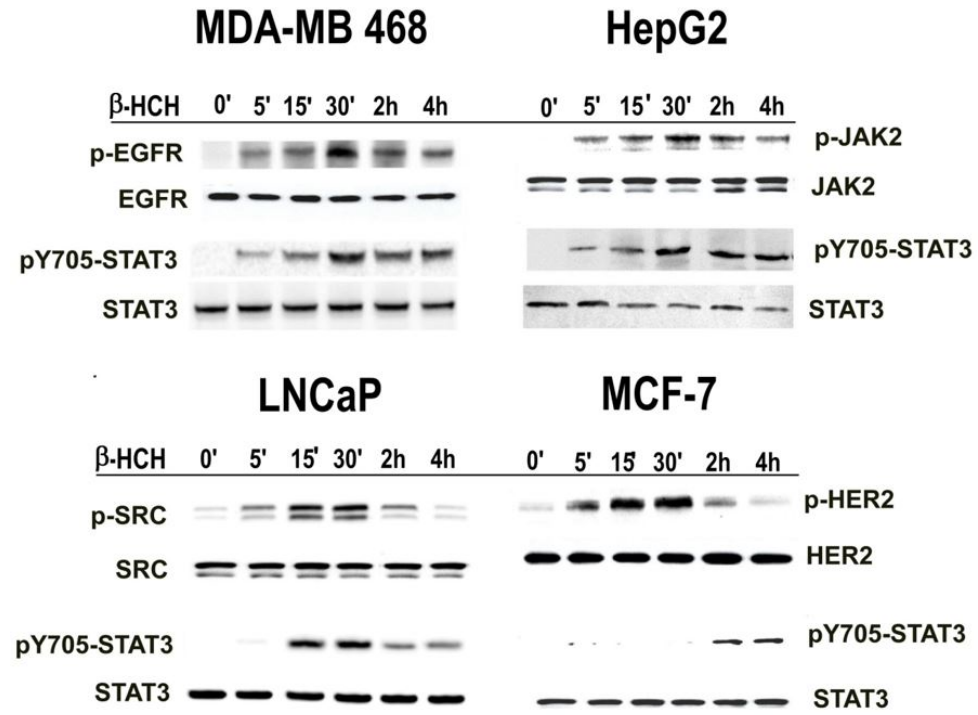
Figure 1. Evaluation of the signaling pathways triggered by β -hexaclorocyclohexane ( β -HCH). Immunoblot analysis of the time-course assay performed on human prostate cancer (LNCaP), human breast cancer (MCF-7 and MDA-MB 468), and human hepatoma (HepG2) cells treated with 10 µ M β -HCH. Samples were analyzed for signal transducer and activator of transcription 3 (STAT3) and each cell line for a specific membrane or membrane associated tyrosine kinase receptor: EGFR in MDA-MB 468 cells, JAK2 in HepG2 cells, SRC in LNCaP cells and HER2 in MCF-7 cells. Both unmodified and the corresponding phosphorylated form were detected for each protein using specific